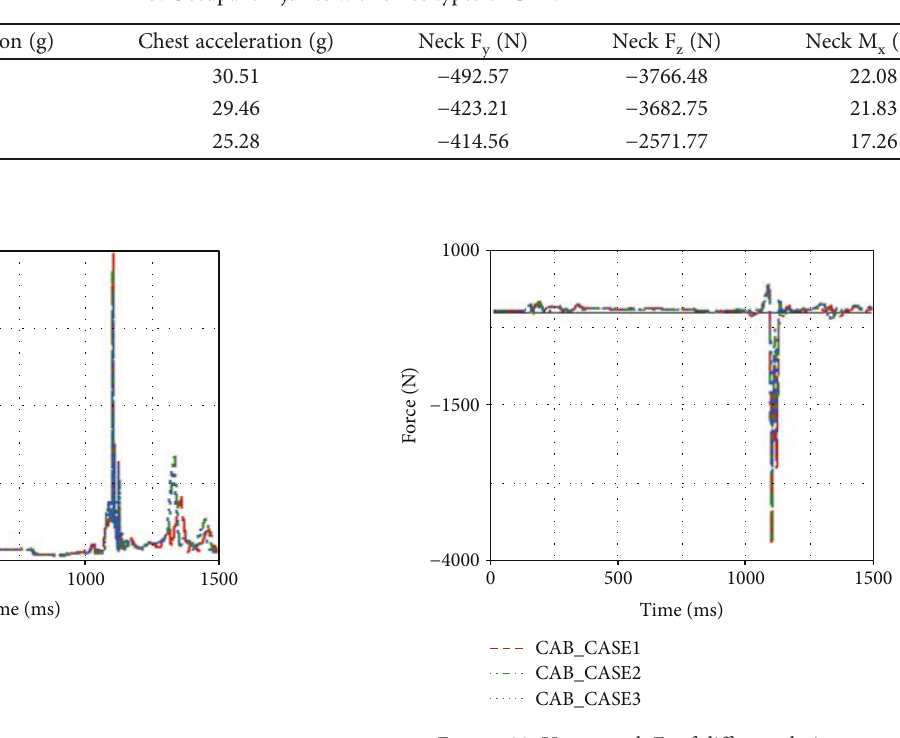
Figure 18: Three types of CAB with di ff erent protection areas. Table 3: Occupant injuries with three types of CAB.